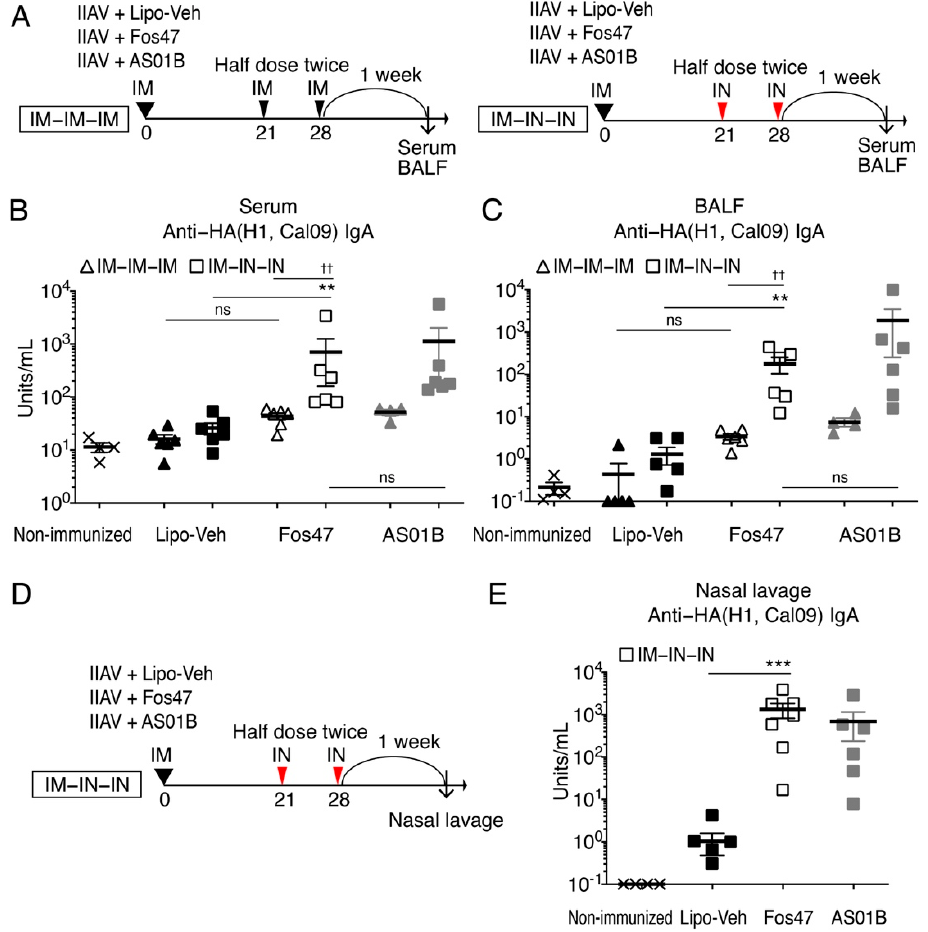
Figure 1. IgA antibody titers in serum and BALF were enhanced by IN boosting with Fos47. ( A ) Experimental protocol. Female BALB/c mice ( n = 6/group) were IM primed with IIAV plus Lipo-Veh, Fos47 or AS01B on day 0. The mice were either IM or IN boosted with a half dose of the same vaccine on days 21 and 28. Lipo-Veh and AS01B served as negative and positive controls, respectively. The mice were sacrificed on day 35 and BALF and serum were collected. Non-immunized mice served as a negative control. ( B ) HA(H1, Cal09)-specific serum IgA. ( C ) HA(H1, Cal09)-specific BALF IgA. Bars indicate means ± SEM. ** p < 0.01, ns; there was no significant difference, Kruskal–Wallis with Dunn’s post hoc test among 4 groups (IM-Lipo-Veh, IM-Fos47, IN Lipo-Veh and IN-Fos47). †† p < 0.01, ns; there was no significant difference, two-tailed Mann–Whitney U -test to compare two groups (IM-Fos47 vs. IN-Fos47 or IN-Fos47 vs. IN-AS01B). ( D ) Female BALB/c mice ( n = 6–7/group) were IM primed and IN boosted with IIAV plus Lipo-Veh, Fos47 or AS01B. Nasal lavage specimens were collected on day 35 to test IgA levels. ( E ) Anti-HA(H1, Cal09) IgA antibody titers in nasal lavage. Bars indicate means ± SEM. *** p < 0.001, two-tailed Mann–Whitney U -test to compare two groups (IN-Lipo-Veh vs.